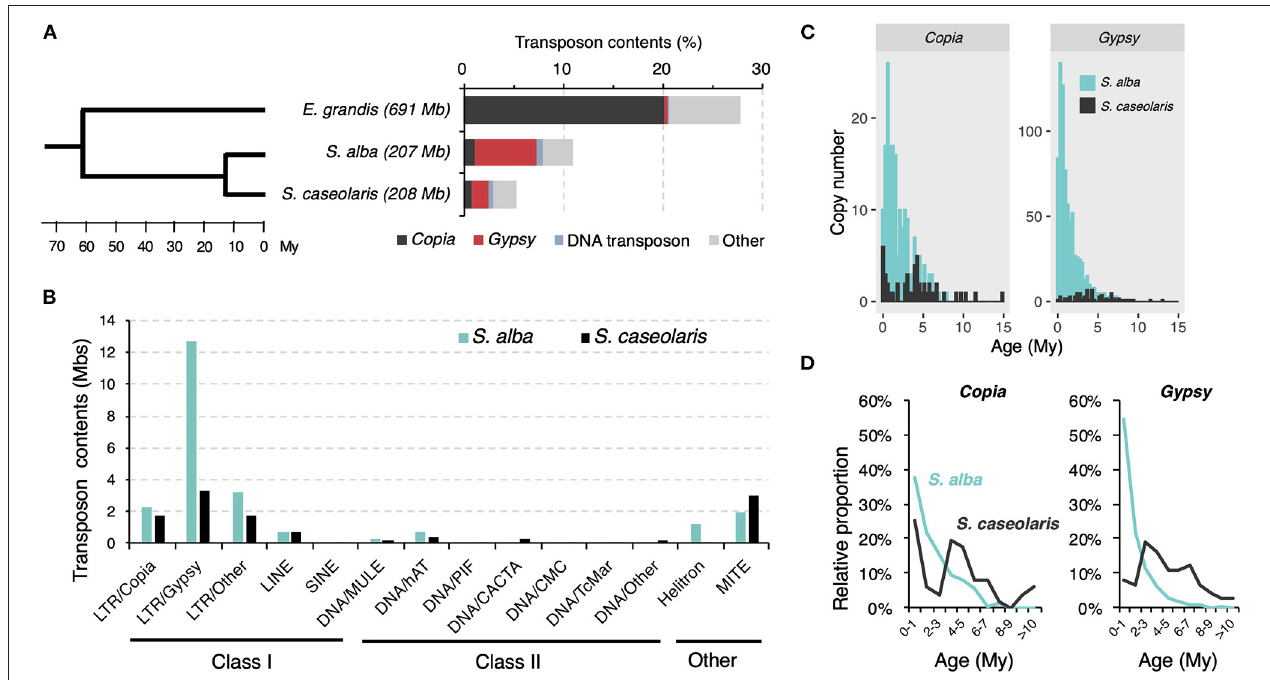
FIGURE 1 | TE composition in Sonneratia alba and S. caseolaris . (A) Bar plot shows the proportions of transposon groups in S. alba, S. caseolaris , and Eucalyptus grandis (the outgroup). Tree topology is adopted from Lyu et al. (2018). (B) Histogram shows the distribution of transposon contents across families between S. alba and S. caseolaris . (C) Histogram shows the copy number of Copia and Gypsy elements in S. alba and S. caseolaris grouped by age. (D) Line graph shows the relative proportion of total Copia and Gypsy elements in different age